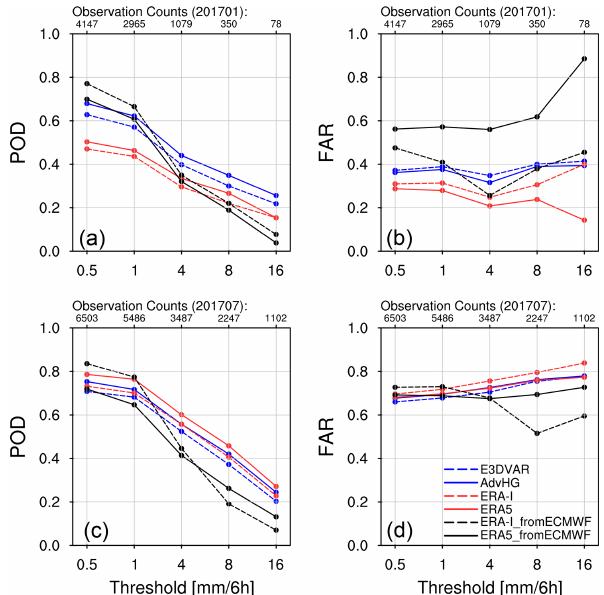
Figure 9. (a, c) POD and (b, d) FAR for (a, b) January and (c, d) July 2017 depending on thresholds 0.5, 1, 4, 8, and 16mm per 6h.